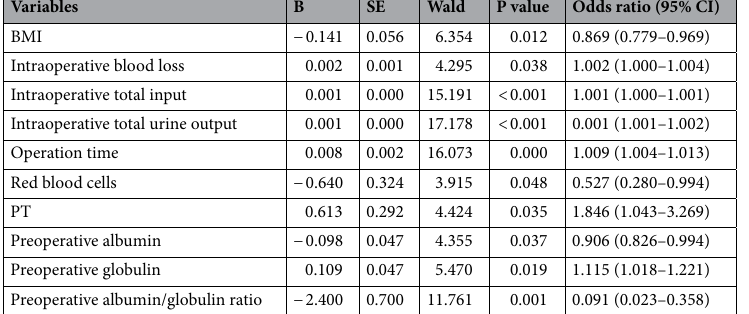
Table 3. Univariate logistic regression analysis of risk factors influencing postoperative hypoalbuminemia in the patients underwent craniotomy for brain tumor. BMI Body Mass Index, B regression coefficient, SE standard errors of regression coefficient, PT prothrombin time.